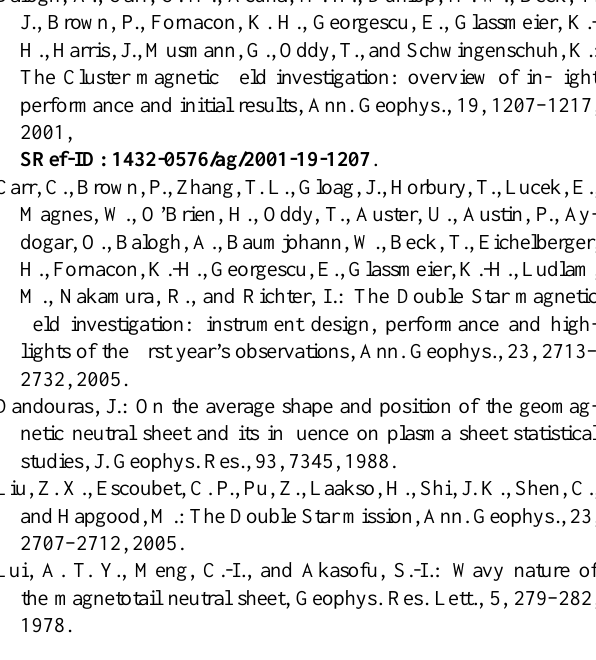
Fig. 4. Schematic view of the kink-like wave emitted from the central part of the magnetotail and propagates toward the tail flanks. The TC-1 and Cluster were located 5Re apart at same local time. For the first time, the wave has been observed at two different magnetotail locations simultaneously. Based on this study and earlier observations, this dawn-dusk wave can be observed at tailward distances of ∼ 11 to 30Re. The magnetopause envelop is produced from Orbit Visualization Tool (K. Stasiewicz, M. Khotyaintsev and Y. Khotyaintsev, http://ovt.irfu.se).